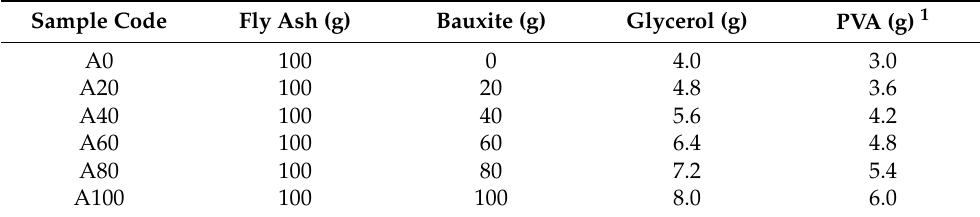
Table 1. Detailed compositions of ceramic supports. 1 The concentration of the PVA solution is 10